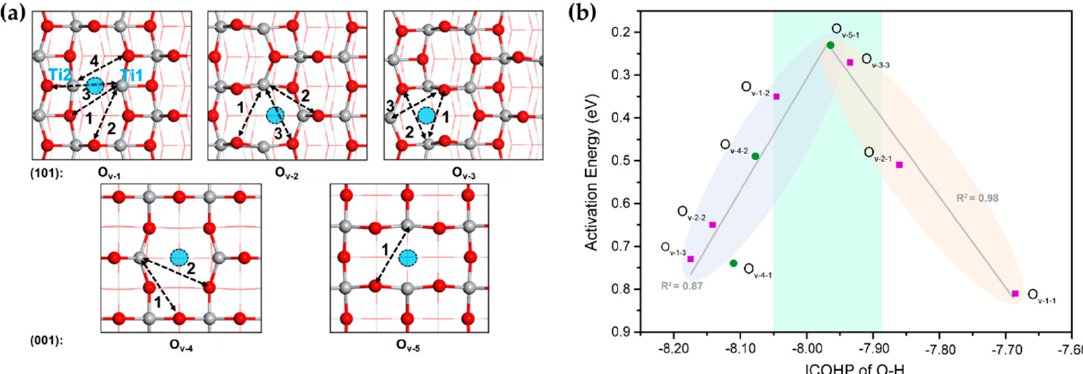
Figure 5. ( a ) Potential FLPs assembled by Ti and O on anatase TiO 2 (101) and TiO 2 (001) with O v s (denoted by blue circles). ( b ) Correlations between the integration of crystal orbital Hamilton population (ICOHP) of O–H with H 2 activation energy, based on PBE-D3 via VASP. Adapted from reference [80] with permission.